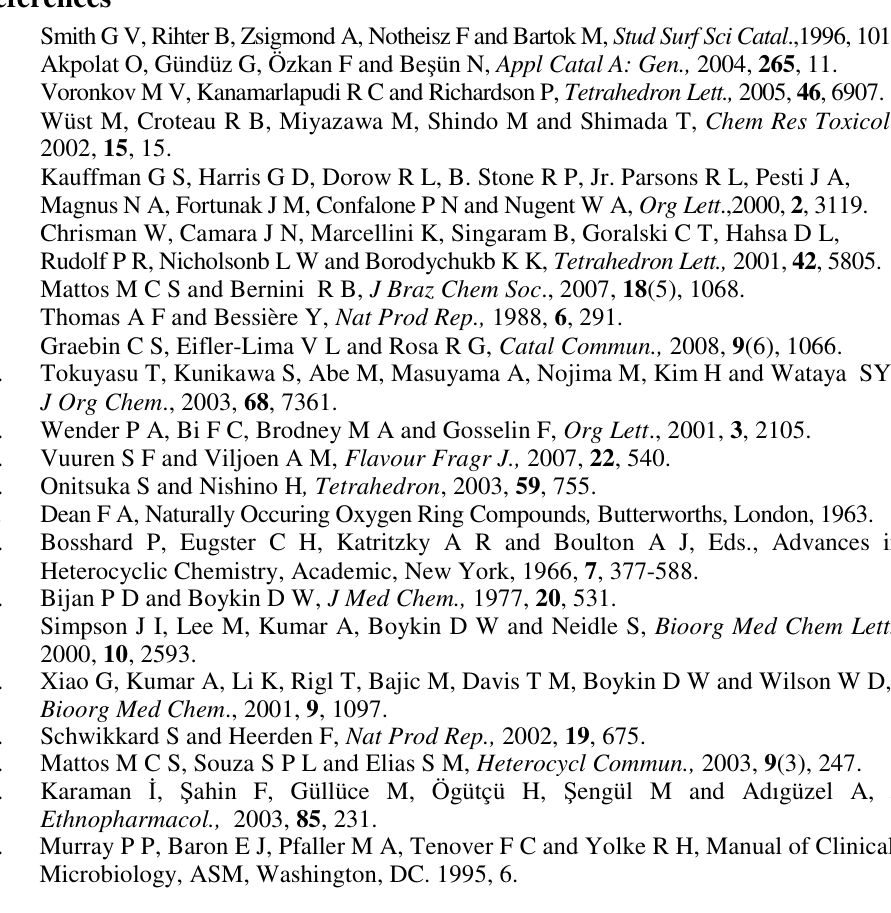
SCF: Sulbactam (30 µg)+cefoperazona (75 µg) = positive control CH 3 OH: Methanol = negative control - : No effect A: Proteus Vulgaris KUEN 1329, B: Candida utilis KUEN 1031, C: Streptococcus homilis, D: E. coli 111, E: Bacillus cereus DSM 4312, F: Pseudomonas aeruginosa ATCC 9027, G: Bacillus subtilis ATCC 6633, H: S. Aureus ATCC 29213, I: Salmonella enteridis ATCC 13076, J: St. Pyogenez ATCC 176, K: Enterococous fecaelis ATCC 29122, L: Candida albicans ATCC